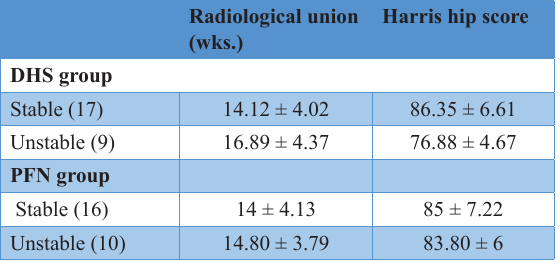
Table 3. Subgroup analysis of Functional outcome and Union between DHS and PFN groups